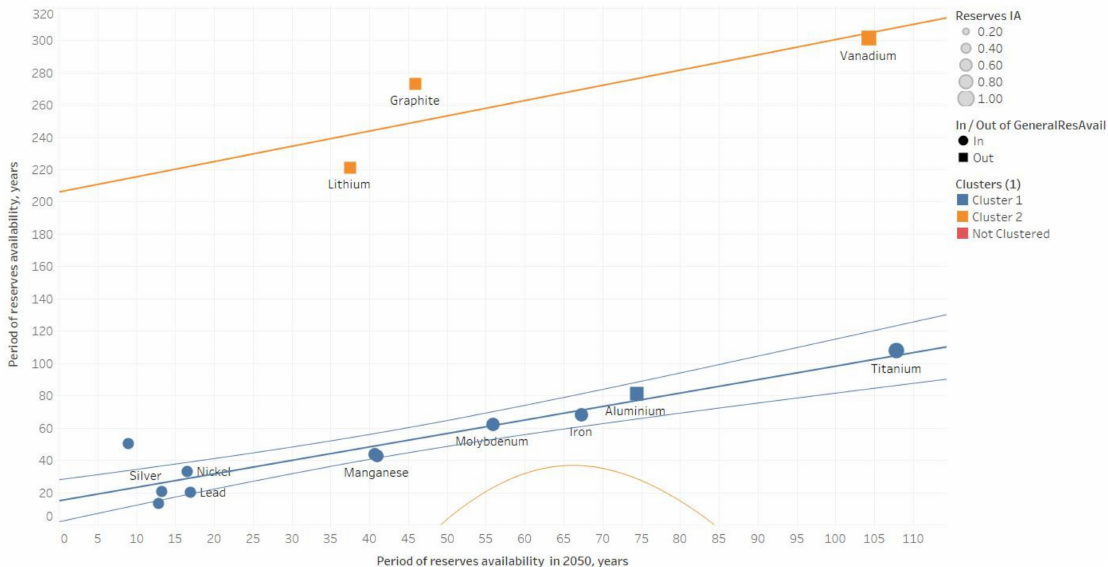
Figure 2. Scatterplot of periods of metal reserves availability with and without correction fort he projected growth in demand in 2050. Colours show two identified clusters. Calculated Reserves IA (see explanation below) shown by symbol size. Linear trend lines and their confidence levels shown by bold and simple lines with colours corresponding to